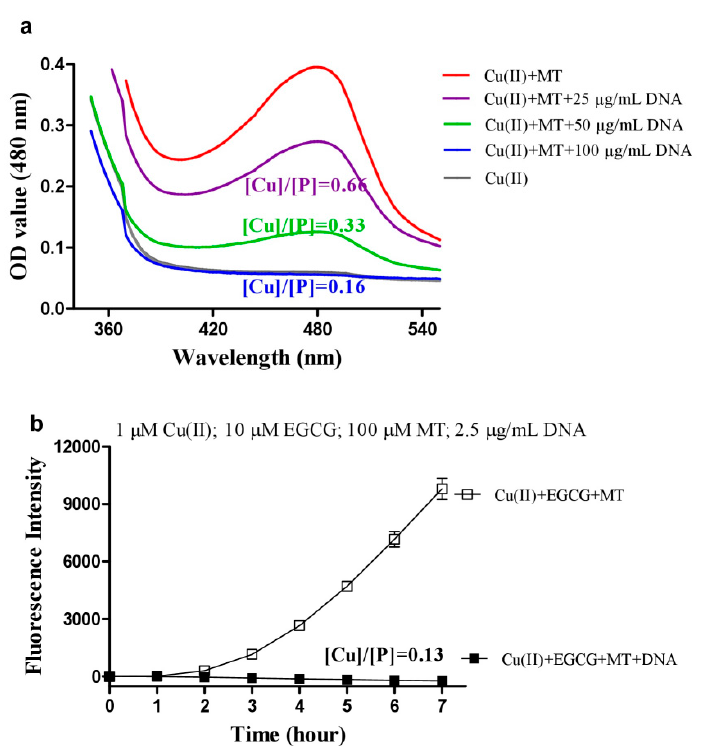
Figure 6. Influence of DNA on melatonin’s actions. ( a ) Detection of melatonin induced Cu(I) production in the presence of DNA. Reaction mixture contained 0.3 mM BCS, 50 µ M Cu(II), 1 mM melatonin (MT), and indicated concentrations of DNA in 0.05 M PBS (pH 7.4), and was incubated at 37 ◦ C for 30 min. ( b ) ROS levels. 1 µ g / mL (DNA concentration) = 3 µ M DNA phosphates (P). [Cu] / [P] is the ratio of the molar concentration of metal ions and DNA phosphates. Chemicals as indicated were mixed in 0.05 M PBS (pH 7.4). Data are presented as the mean of two replicates; the error bar represents the range. In most data points, the range was smaller than the symbol.